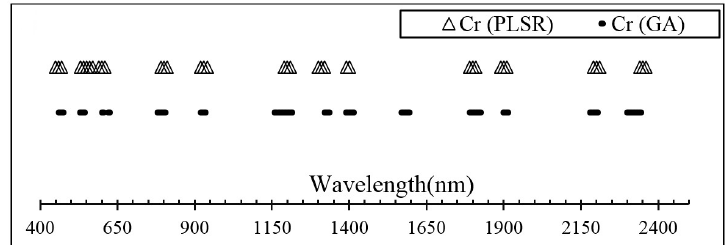
Figure 7. Important wavelengths selected by GA and PLSR